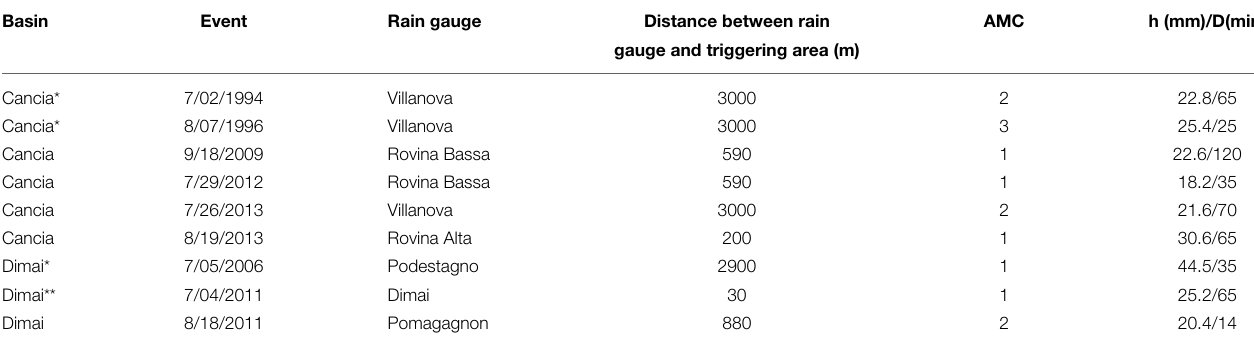
TABLE 2 | Documented events of occurred debris flows in the two basins and the corresponding rainfall